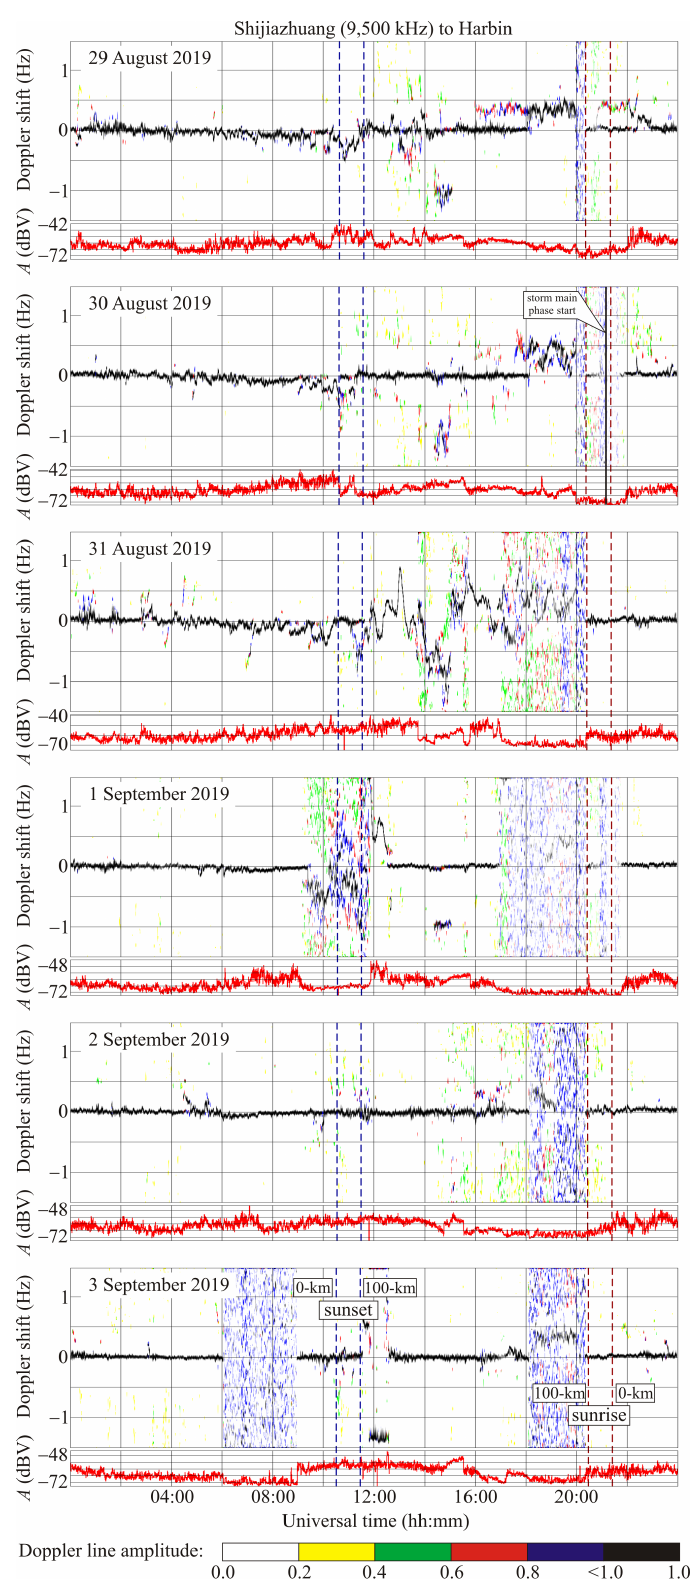
Figure 12. Same as Fig. 5 but for the Shijiazhuang to Harbin radio wave propagation path at 9500kHz.